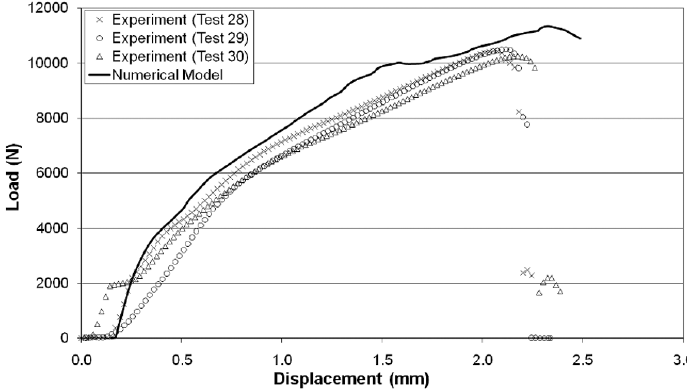
Fig. 12. Comparison with experimental load-displacement data, static shear